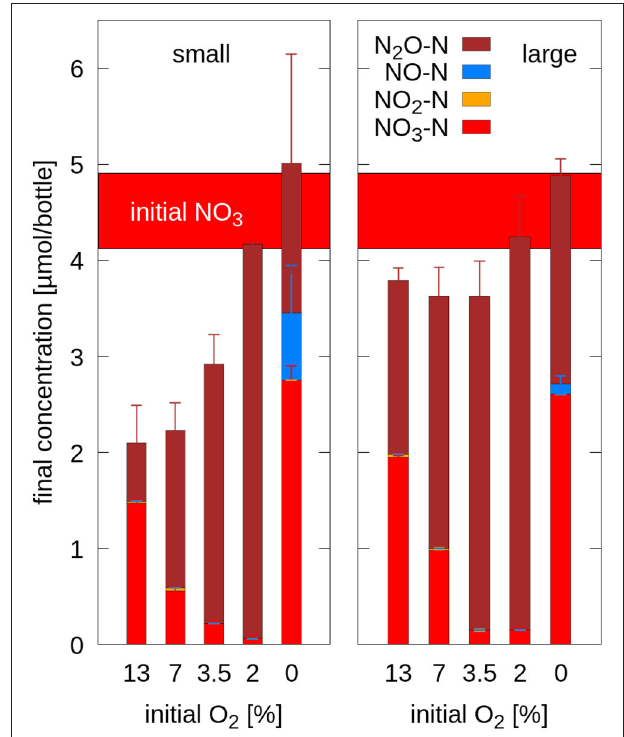
FIGURE 3 | Nitrogen mass balance in small aggregates (Left) and large aggregates (Right) after 45h of incubation at different initial O 2 concentrations depicted as the sum of NO − 3 -N (supplied with the medium), accumulated denitrification intermediates (NO − 2 -N, NO-N) and the final product (N 2 O-N). The estimated amount of initial NO − 3 -N is depicted as a horizontal